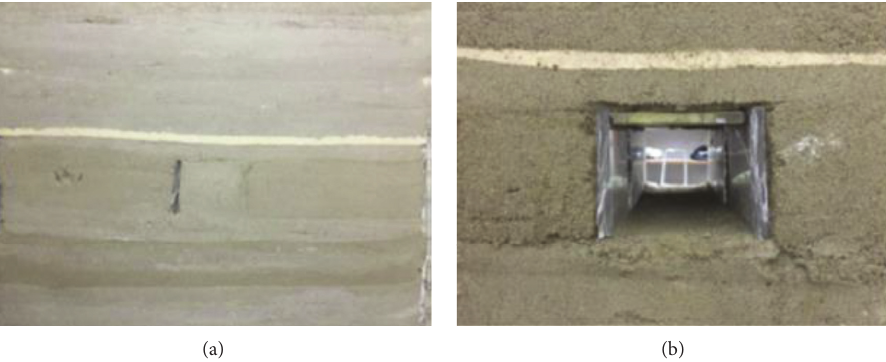
Figure 9: The state of roadway model. (a) Plastic zone under anchor bolt support. (b) The state of the model after excavation.